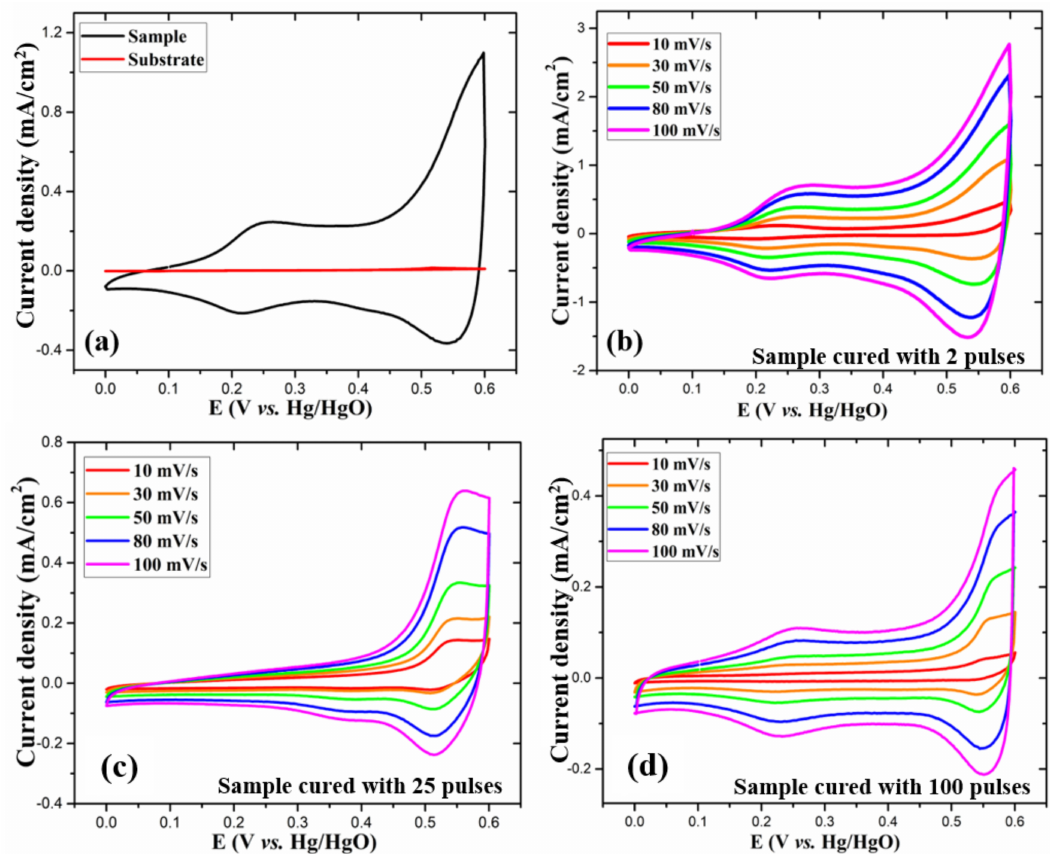
Figure 6. ( a ) CV curves at 30 mV/s scan rate for 2 pulses cured electrode and the bare substrate and ( b - d ) CV curves at various scan rates for the 2, 25, and 100 pulses cured electrodes,